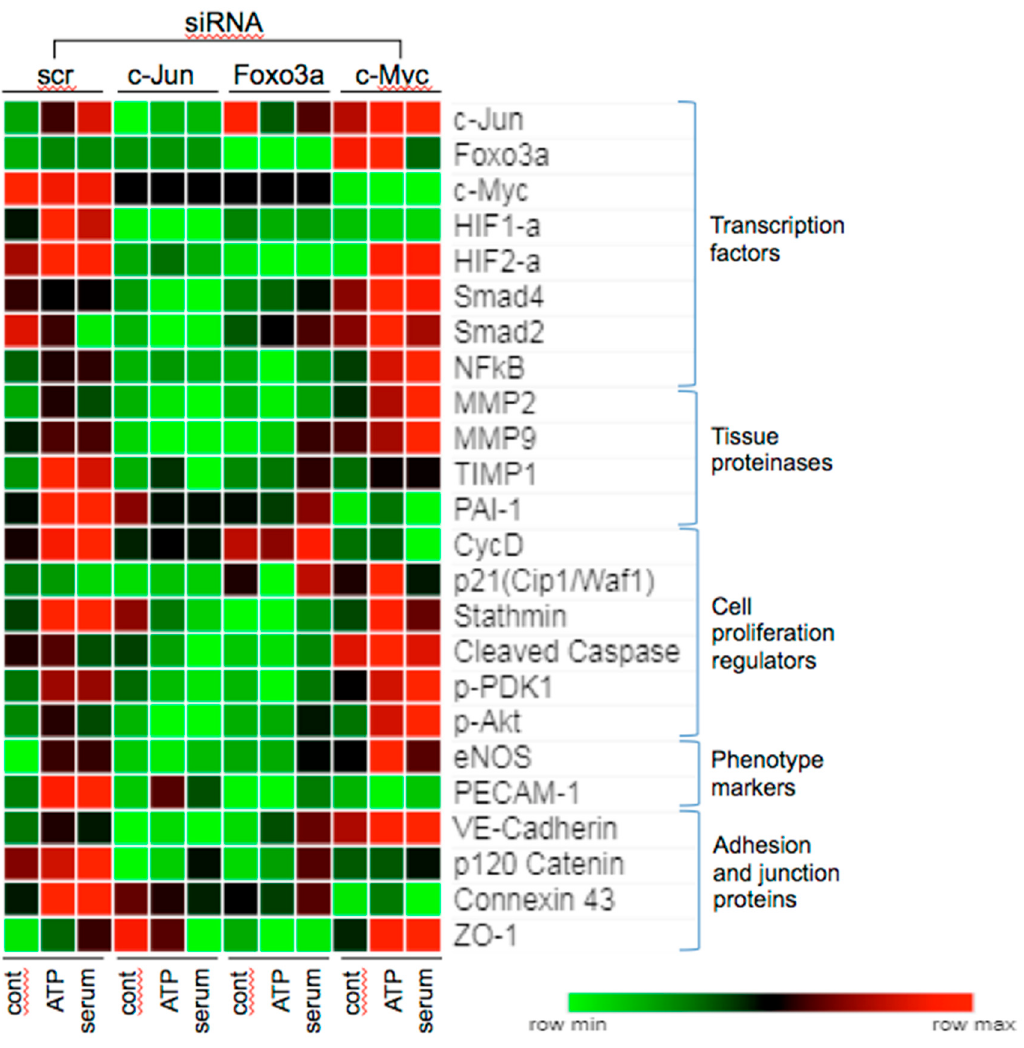
Figure 6. Effect of c-Jun, Foxo3a, and c-Myc siRNA on the expression of select angiogenesis associated proteins. VVECs were transfected with scrambled siRNA or siRNA to c-Jun, Foxo3, and c-Myc as described in the Materials and Methods Section. Cells were stimulated with ATP (100 μ M, 24 h) or serum (FBS, 1% in DMEM, 24 h), and total lysates were subjected to Western blot (WB). Heatmap (Morpheus Analysis Software) was plotted based on densitometric analysis of WB data (normalized to non-stimulated scramble siRNA-transfected cells). By default, values in the heat map are mapped to colors using a relative color scheme using the minimum and maximum of each row independently. Each square on the heatmap represents a protein of interest normalized to GAPDH (data represent average from three experiments (n = 3) conducted on three cell populations).